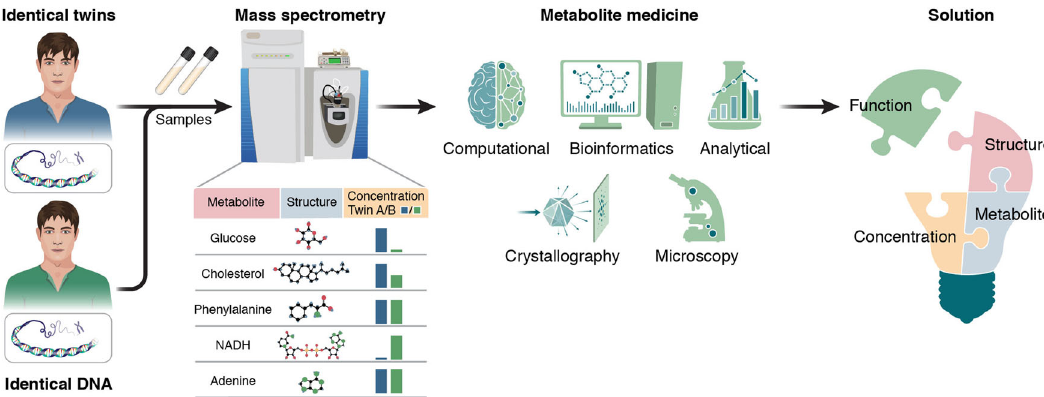
Fig. 1 Metabolite medicine. Standard metabolomics methodologies allow to differentiate between samples, even given an identical genome, as in the displayed example. Yet, the output of such methodologies, namely the levels of diverse metabolites in each sample, requires further analysis to decipher